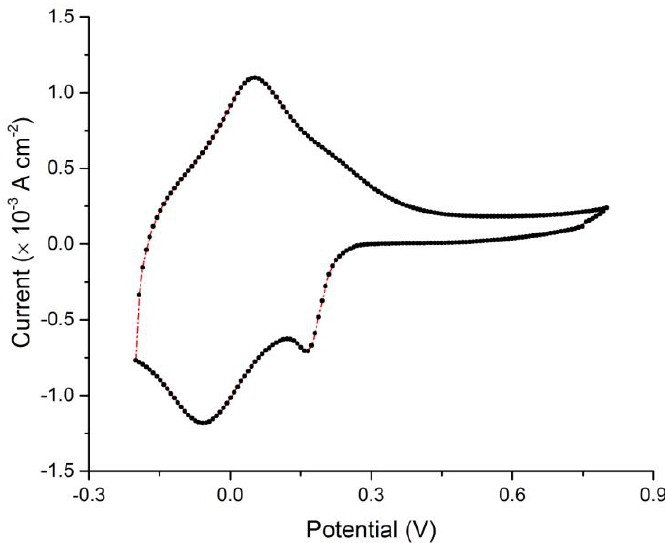
Figure 3: Cyclic voltammogram for the 10 th cycle of the PANI / GPE / PANI redox capacitor with 0.40 M aniline concentration. Sweep rate is 5 mVs -1